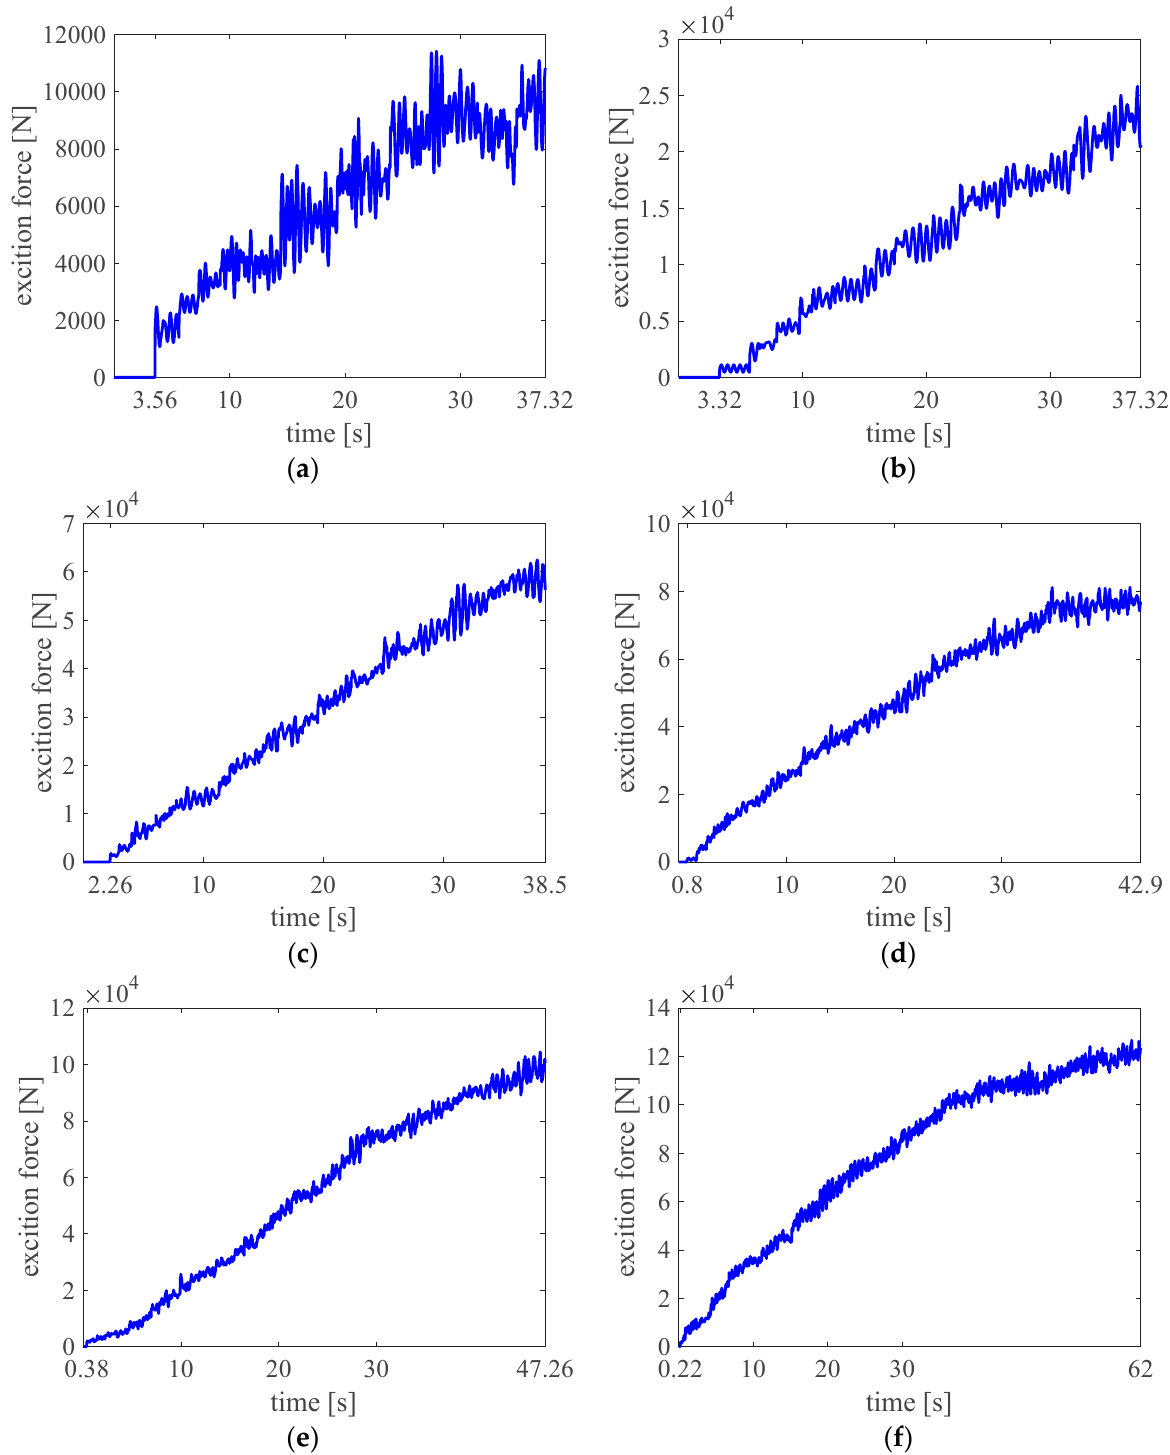
Figure 9. The time history of the crowd-induced loads in the vertical (Z) direction for different pedestrian densities. ( a ) 0.1 pedestrians/m 2 , ( b ) 0.2 pedestrians/m 2 , ( c ) 0.5 pedestrians/m 2 , ( d ) 0.8 pedestrians/m 2 , ( e ) 1.0 pedestrians/m 2 , ( f ) 1.5 pedestrians/m 2 .